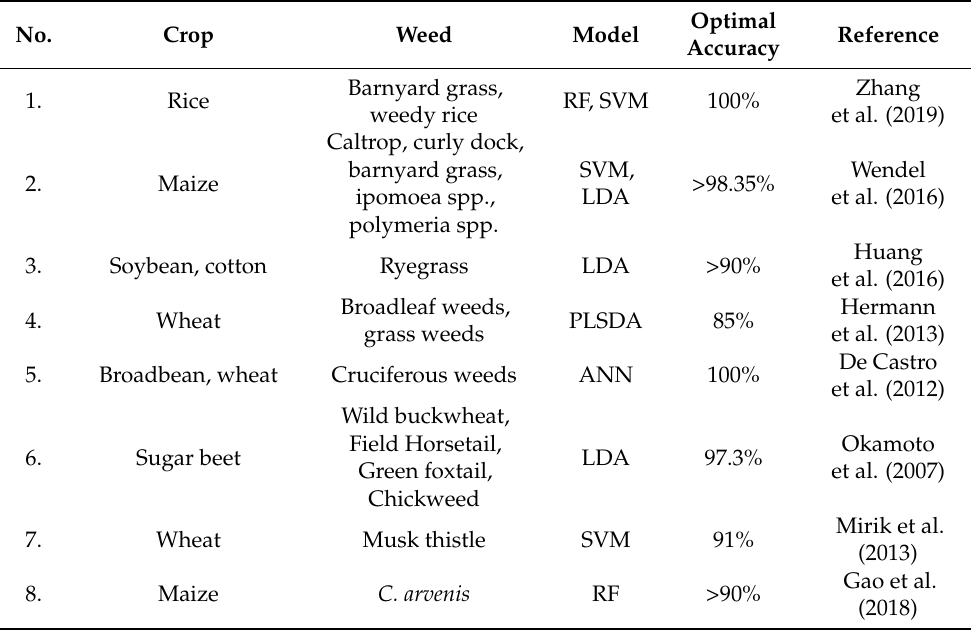
Table 5. Hyperspectral imaging for discrimination of crops from weeds using machine learning (adopted from Su.